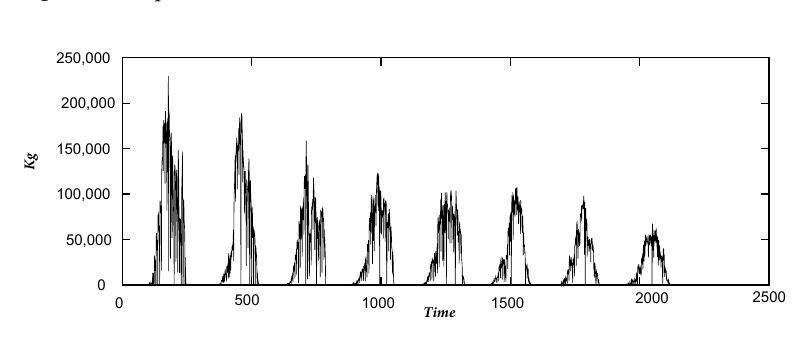
Figure 2. Coop2 time series.